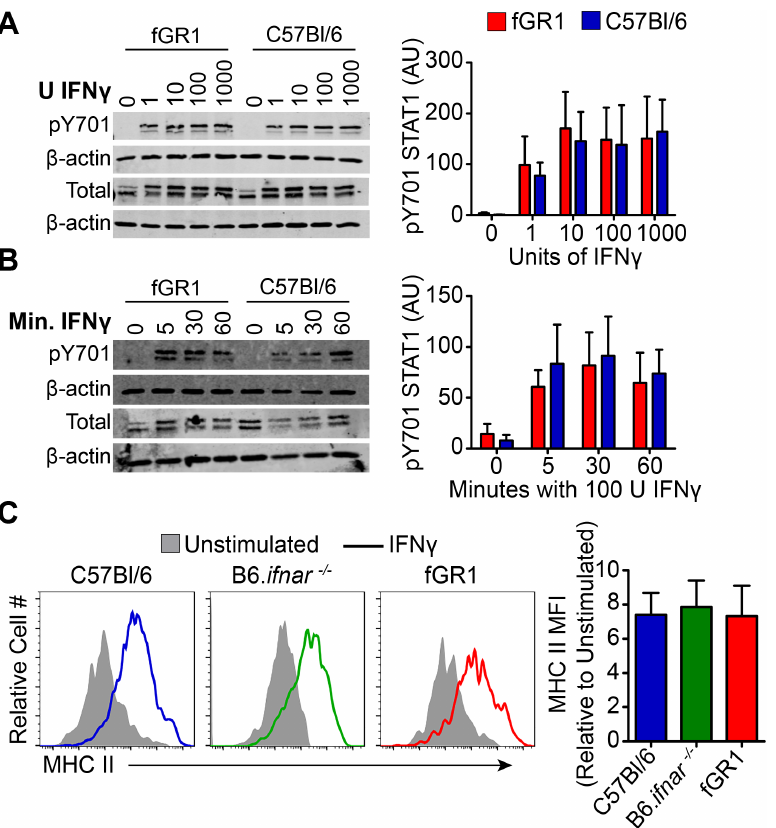
Fig 2. fGR1 expression does not alter basal IFN γ responsiveness. Peritonealmacrophages from na ï ve fGR1 and WT mice were A) stimulated for 30 min with increasingconcentrations of IFN γ , B) 100 U/mL of IFN γ for 5, 30, 60 min and pY701 STAT1 determinedby western blots. pSTAT1 blots were normalizedto β -actin, Arbitrary Units (AU). C) Na ï veperitoneal macrophages (CD90.2 -, CD11b hi , F480 hi ) from IFNAR KO (green), C57Bl/6(blue), and fGR1 (red) were stimulatedwith 100 U/mL of IFN γ for 24 hrs and MHC II up regulation evaluatedby flow cytometry. MFIs were normalizedto their respectiveunstimulated controls and pooledfrom multipleexperiments (n = 3 independent experiments, 1–3 mice per